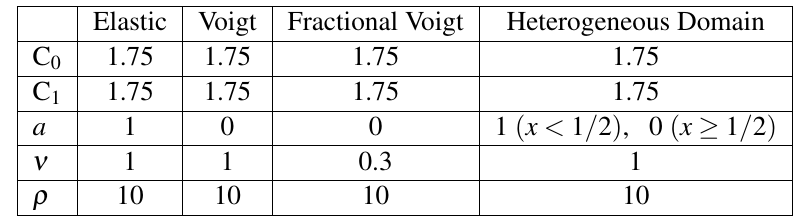
Fig. 7 Space-time plots with parameters described in Table 5 where first and last four subplots correspond to the signals shown on the left and right of Figure 5.